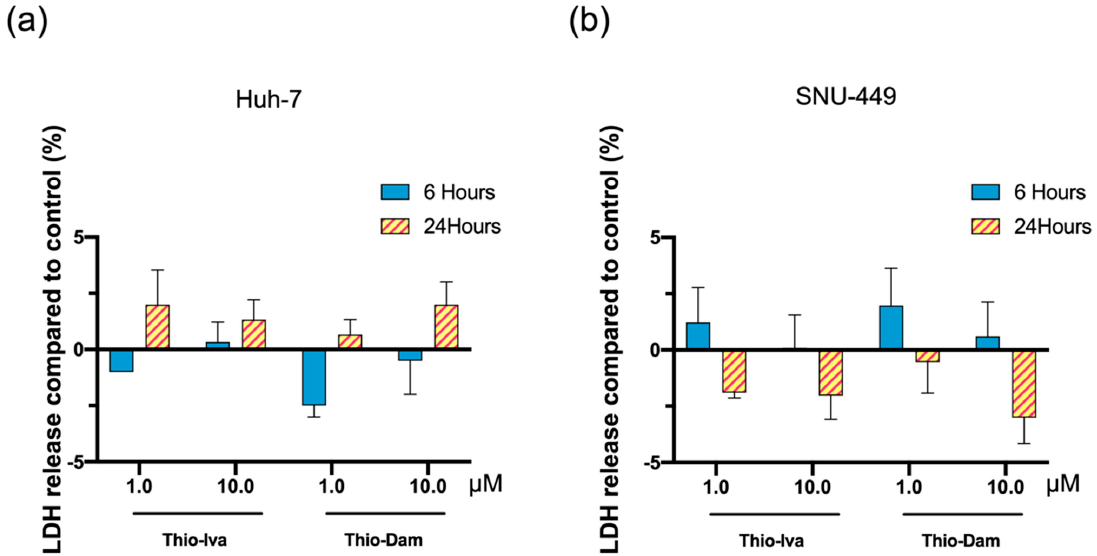
Figure 5. Cytotoxic effects of Thio-Iva and Thio-Dam. Release of lactate dehydrogenase (LDH) after incubation of Huh-7 ( a ) and SNU-449 ( b ) cells with 1 and 10 μ M of Thio-Iva and Thio-Dam for 6 and 24 h, respectively. LDH release was not significantly altered when compared to untreated controls (set to 0%), indicating that unspecific toxicity did not contribute to the observed effects. Means ± SD of n = 3 independent experiments.